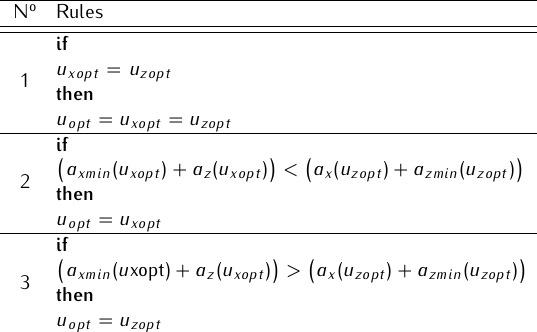
Table 7. Look-up table of rules for the U opt algorithm (for two direc- tions). N o